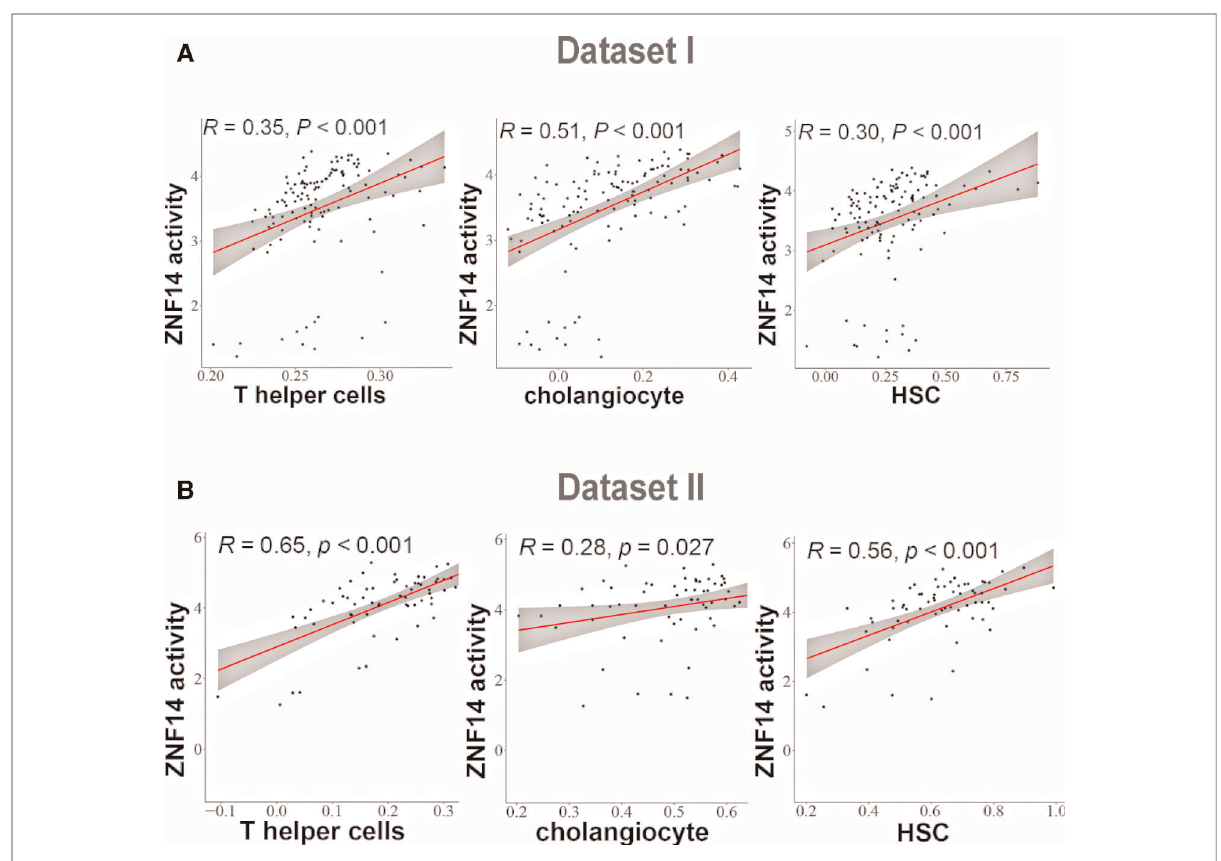
FIGURE 5 Correlation analysis between TFs regulon activity and single sample gene Set enrichment analysis (ssGSEA) scores. ( A ) Linear regression analysis between ZNF14 regulon activity and T helper cells/choanocyte/HSC ssGSEA scores (dataset I). ( B ) Linear regression analysis between ZNF14 regulon activity and T helper cells/choanocyte/HSC ssGSEA scores (dataset